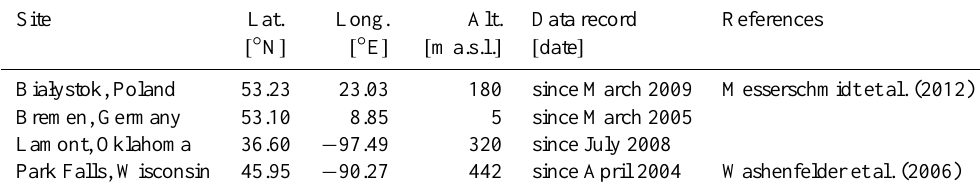
Table 2. TCCON sites (latitude, longitude and altitude). The data record time period and references are listed. Site